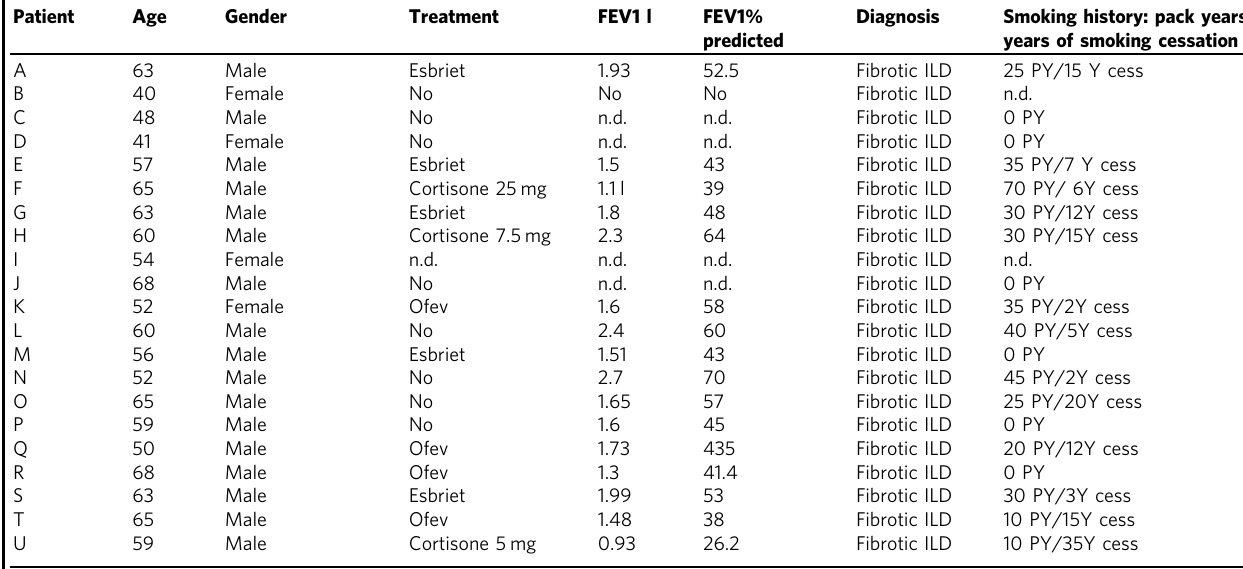
Table 2 Clinical characteristics of patients with fi brotic interstitial lung disease